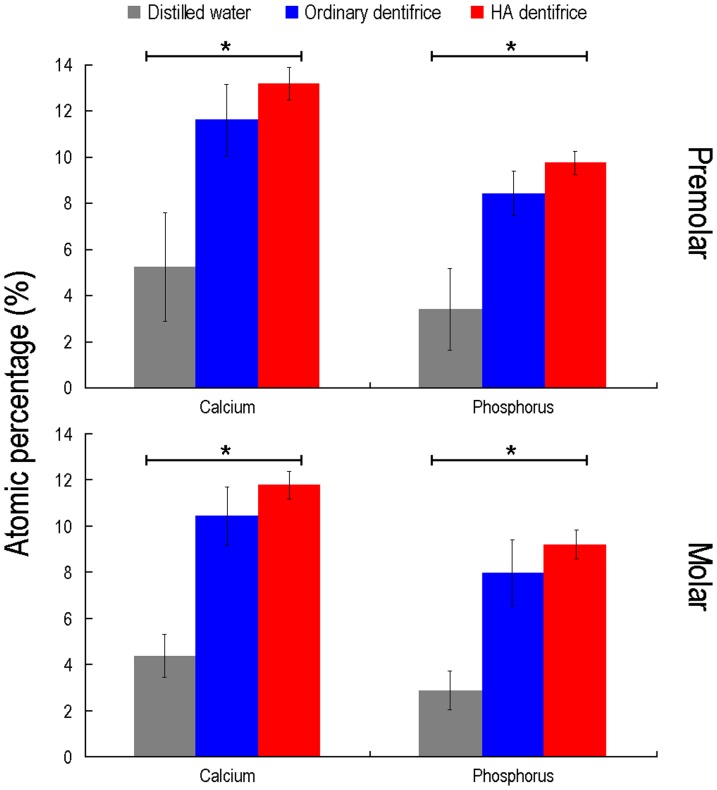
Atomic percentages of calcium and phosphorus in dentine discs.The lines on top of the bars stand for standard deviation. *: P<0.01, the differences of the atomic percentage (n = 8) of Ca or P among groups were statistically significant. Based on mean rank, the order of the atomic percentages of Ca or P is: HA dentifrice group>ordinary dentifrice group>distilled water group.